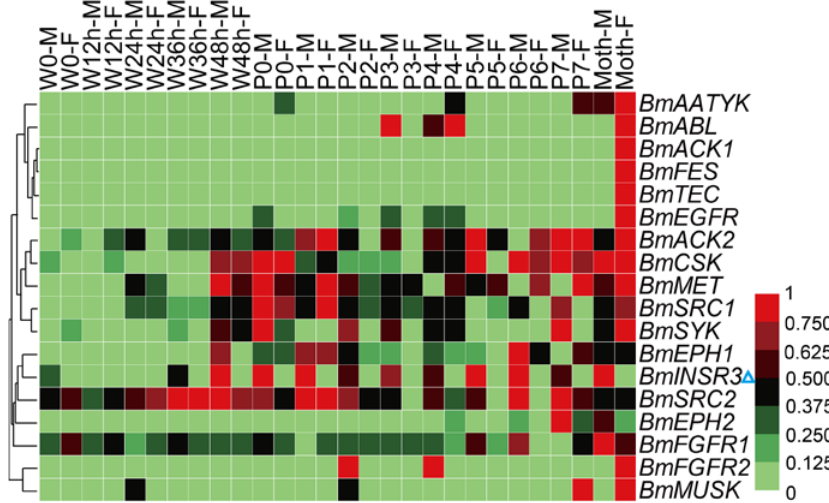
Figure 7. Microarray-based gene expression profiling of BmTK genes during silkworm metamorphosis. 18 BmTK genes were detected to be expressed during silkworm metamorphosis. W: Wandering (W0: beginning of wandering for spinning, W12 h: 12 h after W0), P: pupation (P0: beginning of pupation, P1: one day after P0), M: male, F: female. Blue triangle indicates the gene with male-specific expression.